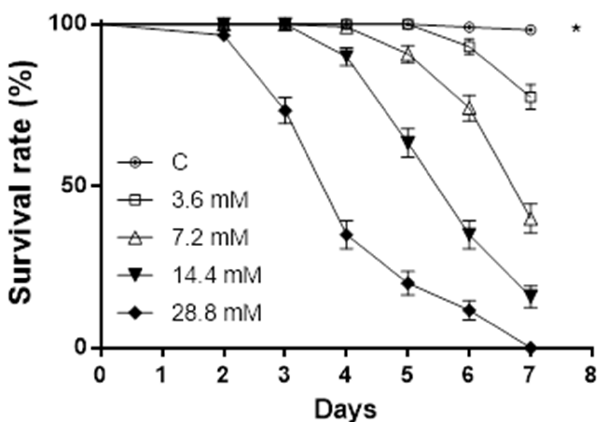
Figure 2. Significant HMBC ( A ) and NOESY ( B ) correlations of 1 .